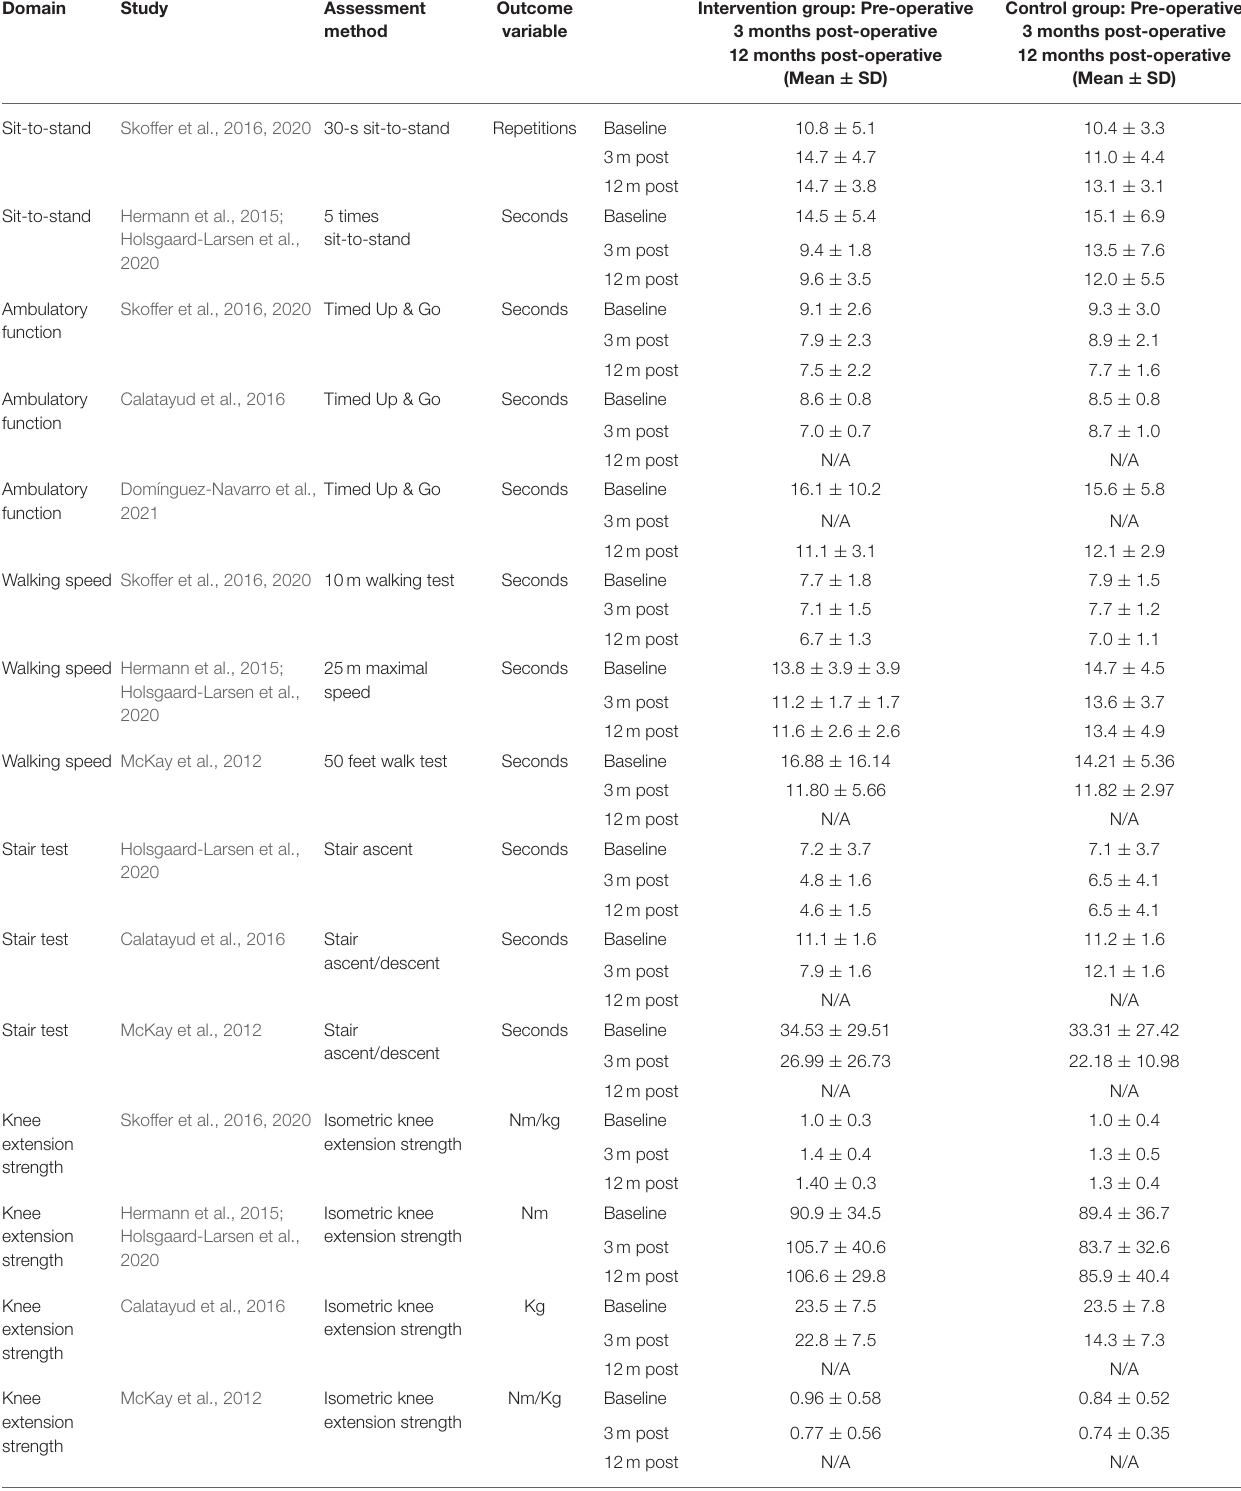
TABLE 2 | Outcome variables from each individual